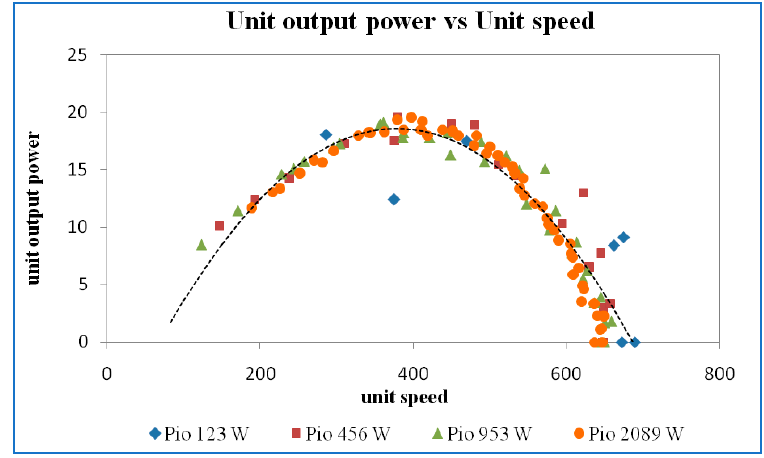
Figure 29. Unit output power vs. unit speed at a guide vane opening of 13 mm. Variation in efficiency versus unit speed is shown in Figure 30. The efficiency gradually increases and decreases. The maximum efficiency is attained at a unit speed of 400 rpm.